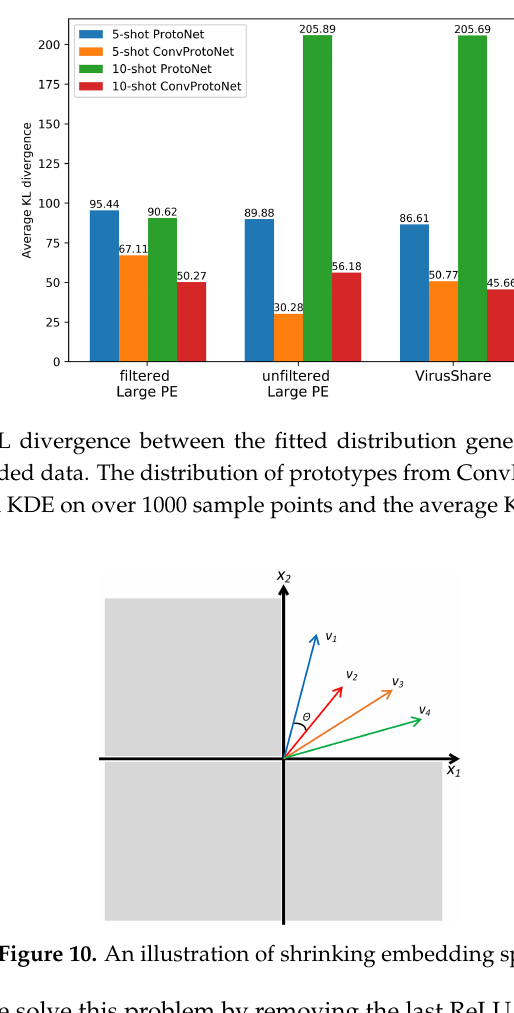
Figure 8. An illustration of distribution mismatch using mean as prototype when data satisfy multimodal distribution.